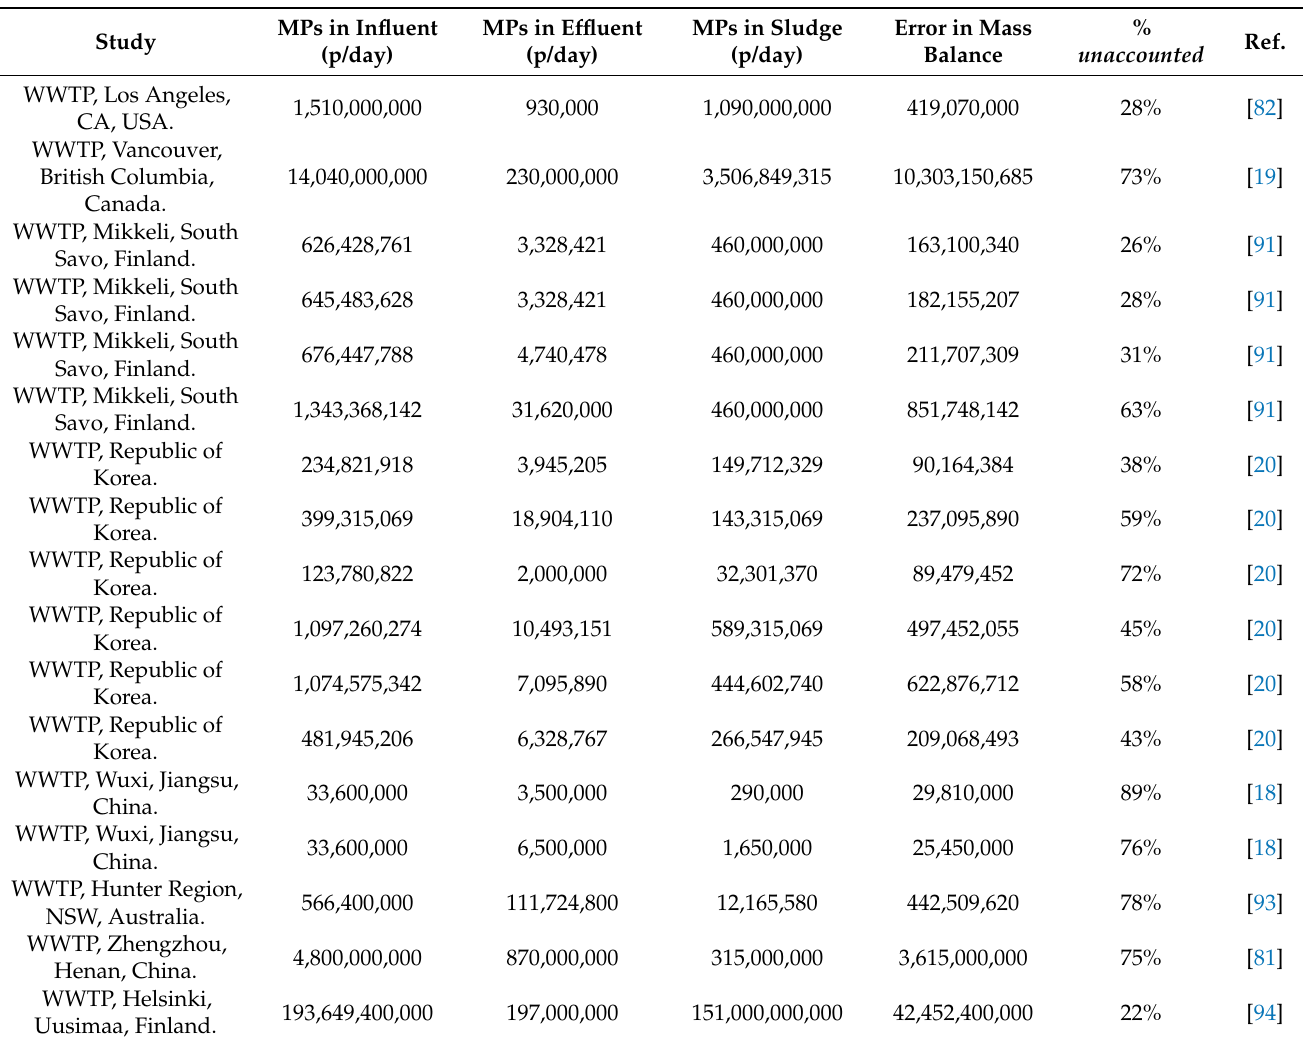
Table 1. Summary of error in mass balance and % of unaccounted MPs in WWTP in several studies across the globe. Adopted with permission from Koutnik, V et al. [14]. unaccounted microplastics in wastewater sludge: where do they go? ACS EST Water 2021 , 1 , 1086–1097, Copyright © 2023, American Chemical